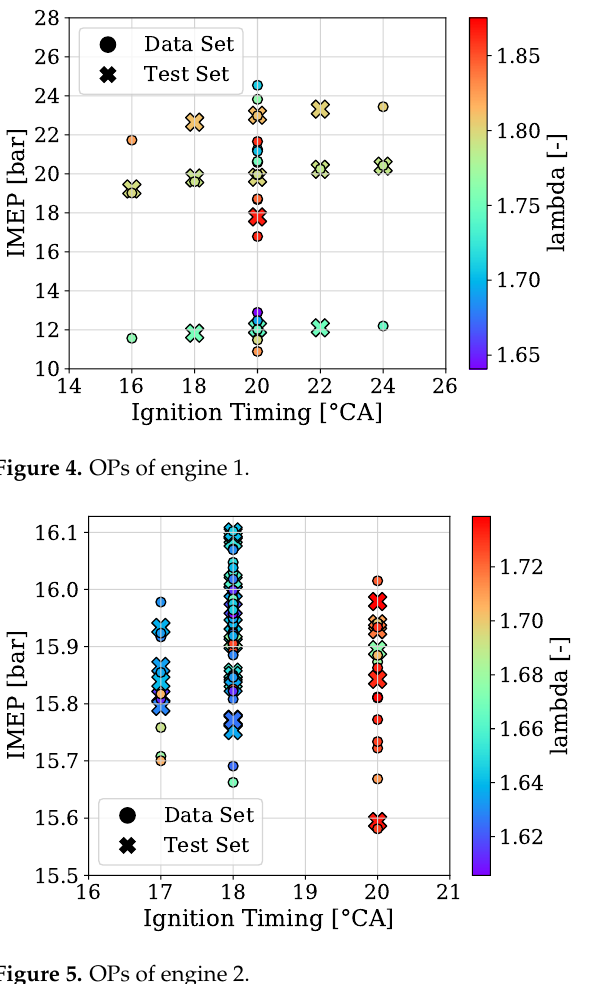
Figure 5. OPs of engine 2.